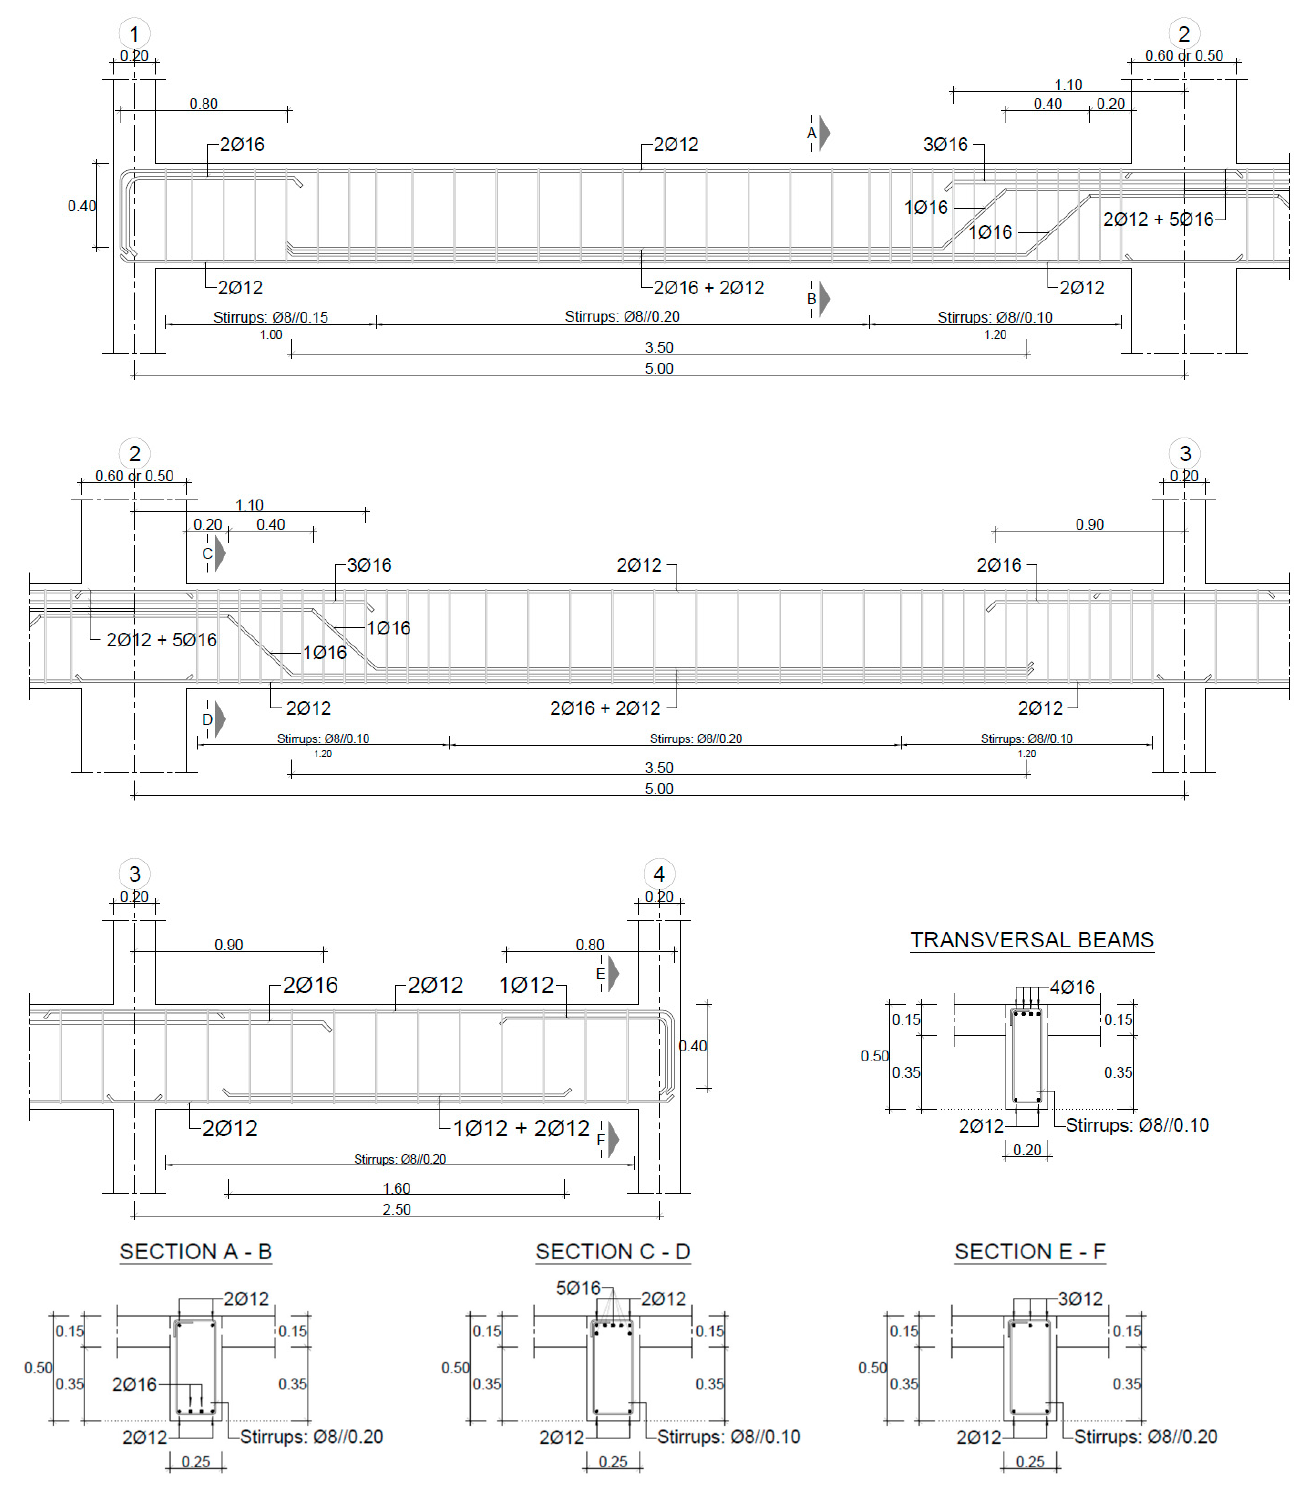
Figure 3. Beam cross-section and reinforcement details (adapted from [8]).